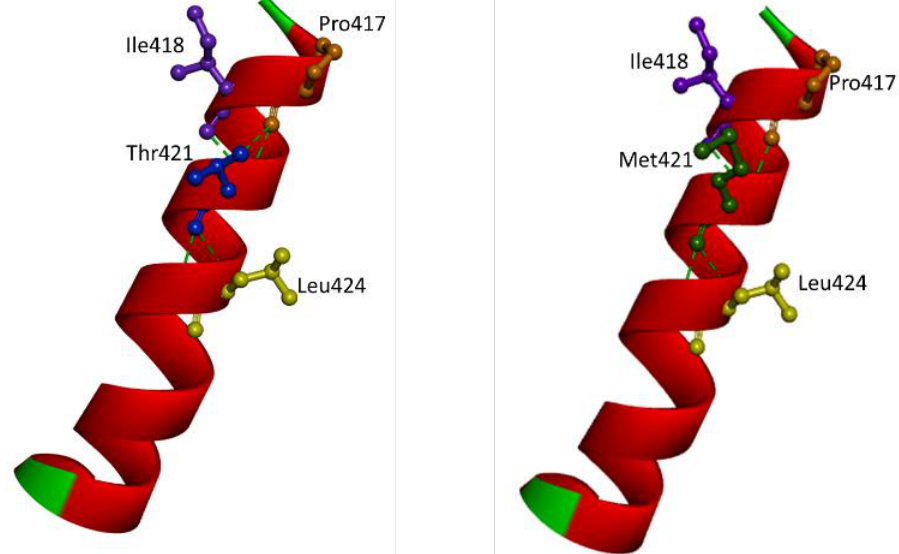
Figure 4. Intramolecular interactions in case of Thr421 and Met421. Mutation may result in a loss of a hydrogen bond with Pro417.